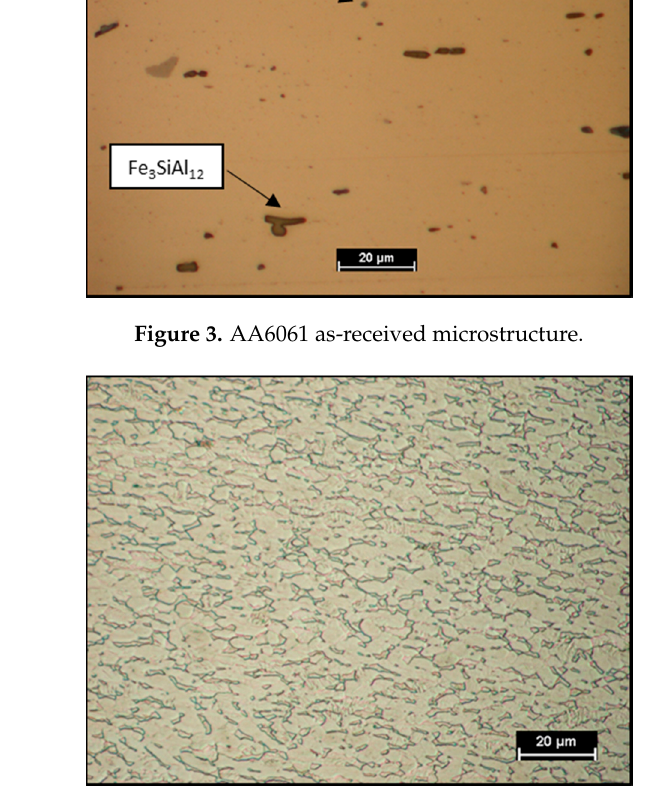
Figure 4. Grade 5 Titanium as-received microstructure.